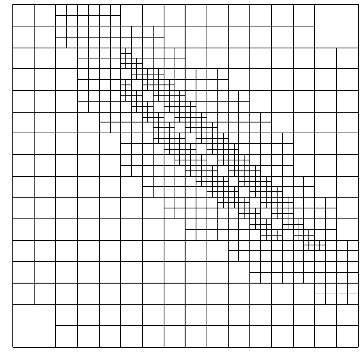
Figure 16. Final mesh π (= π ∗ ) .